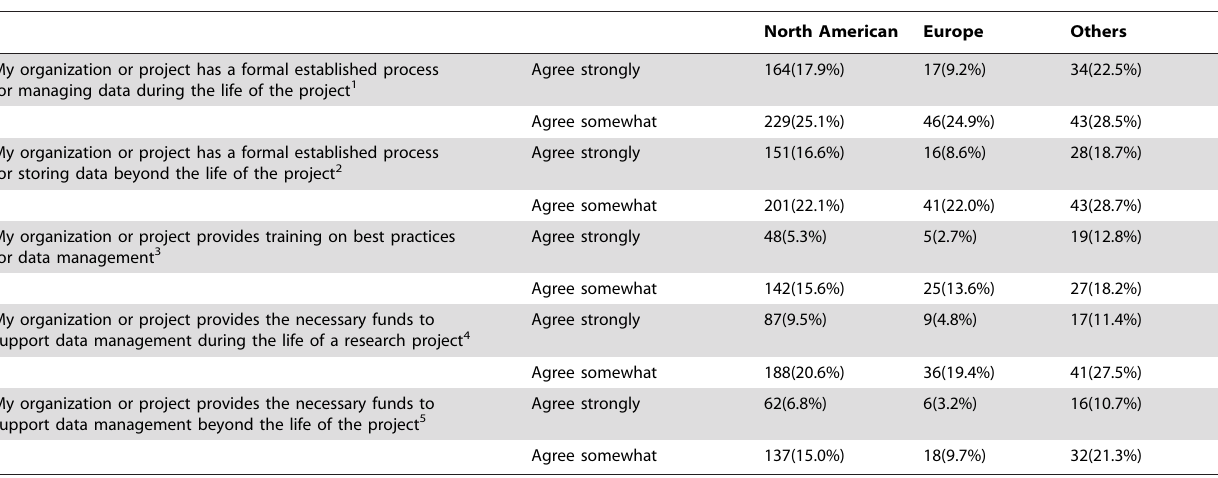
Table 33. Organizational involvement in data issues by geographic location.